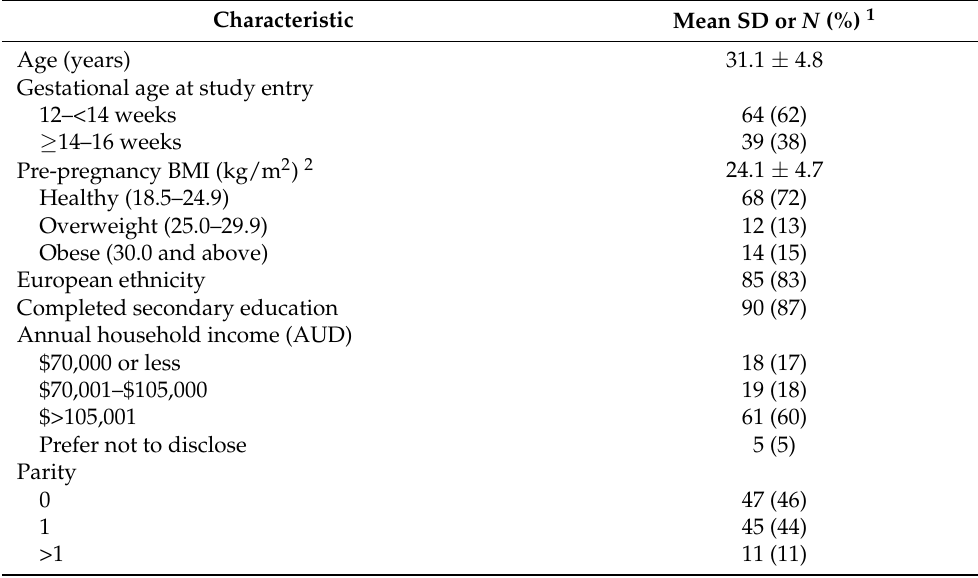
Table 1. Characteristics of participants at study